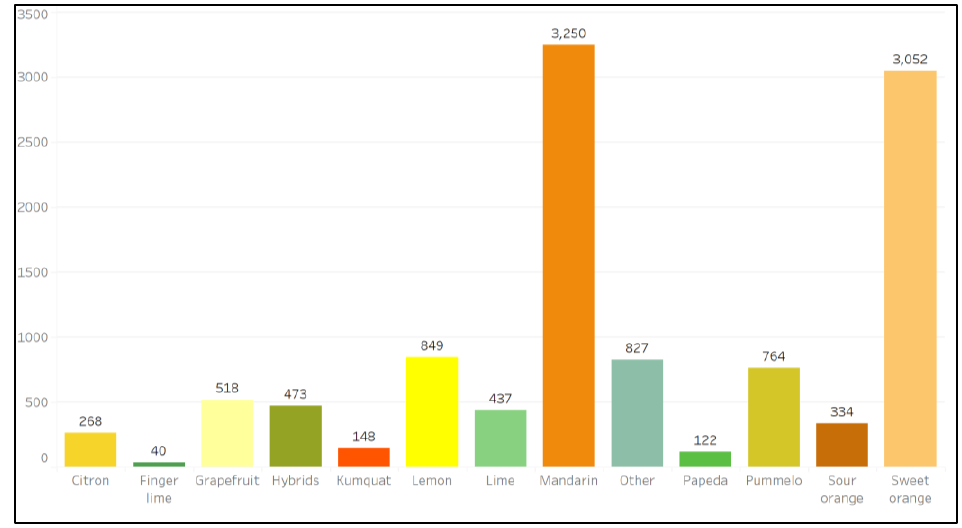
Figure 4. The number of ex situ citrus plant genetic resources reported in all survey responses that are classified as listed fruit types.